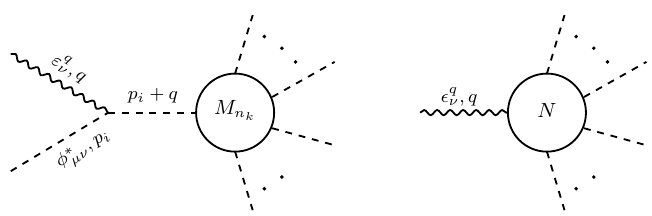
Figure 2 . Diagrams contributing to the interaction amplitude among a soft gauge (cid:12)eld and n Kaluza-Klein